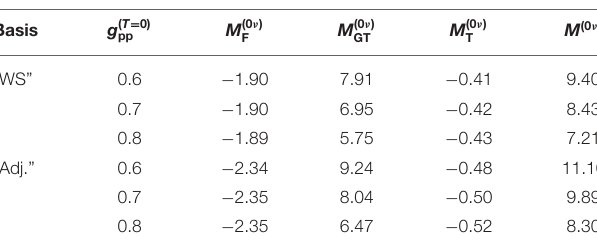
TABLE 3 | Nuclear matrix elements for 0 νβ + β + decay of 106 Cd corresponding to g A (0) = g eff A = 1.0.